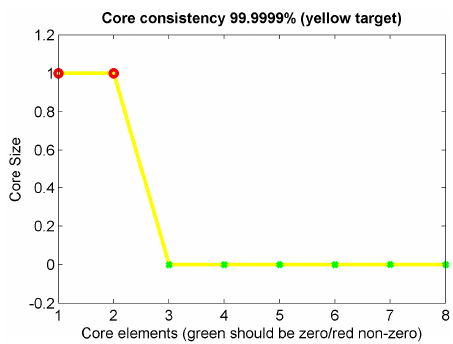
Figure 6. The result of core consistency obtained in the PARAFAC decomposition of original spectral data of different oils.